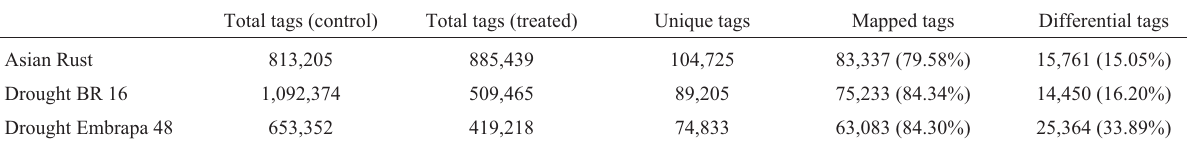
Table 1 - Summary of Solexa SuperSAGE data deposited in the Genosoja databank.